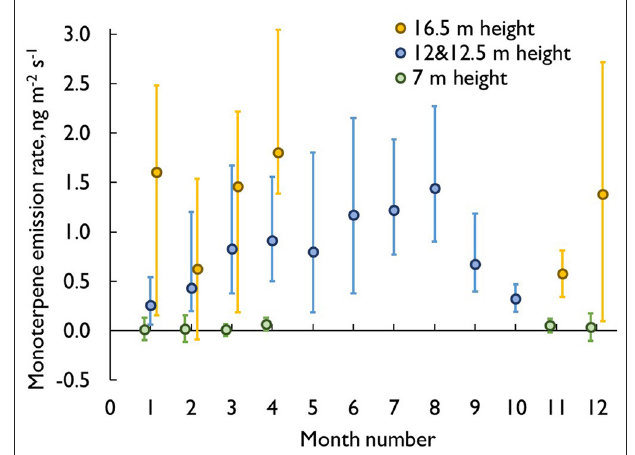
FIGURE 6 | The monthly pattern of the vertical profile in monoterpene emission rates (ng m − 2 s − 1 ). The values are monthly medians and quartiles. shoot transpiration rates are closely linked, and the correlation